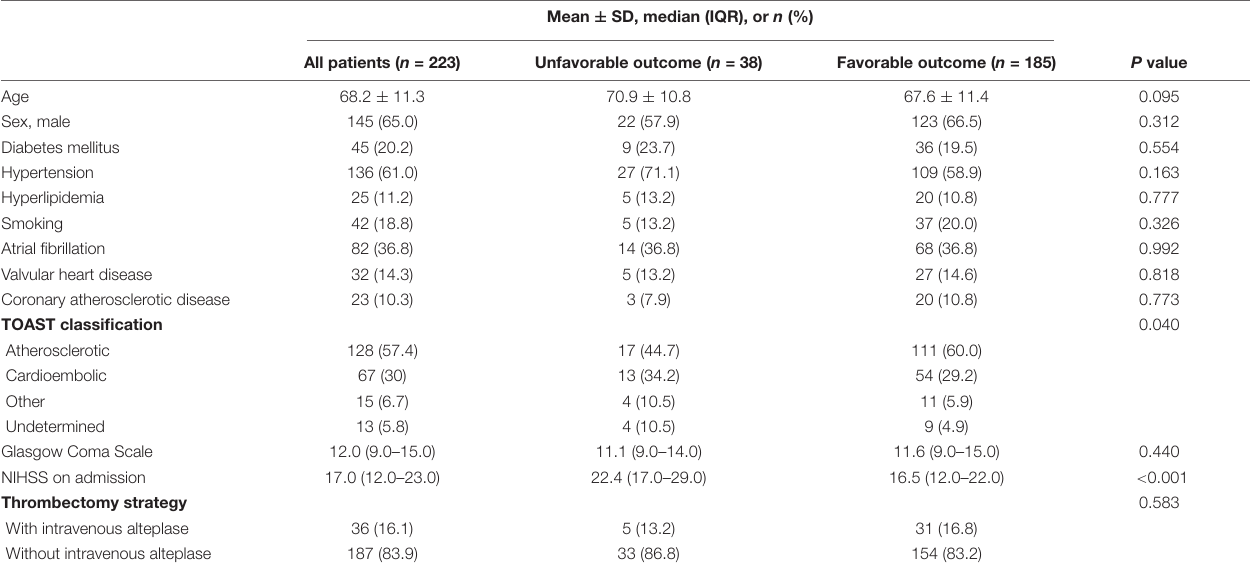
TABLE 1 | Baseline demographic and clinical characteristics ( n =